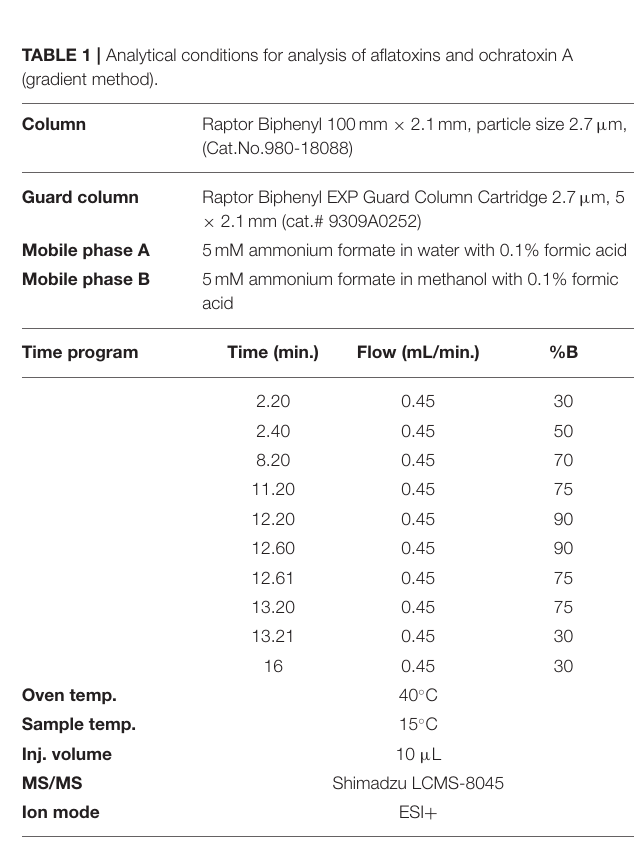
FIGURE 3 | Structure of Ochratoxin A.